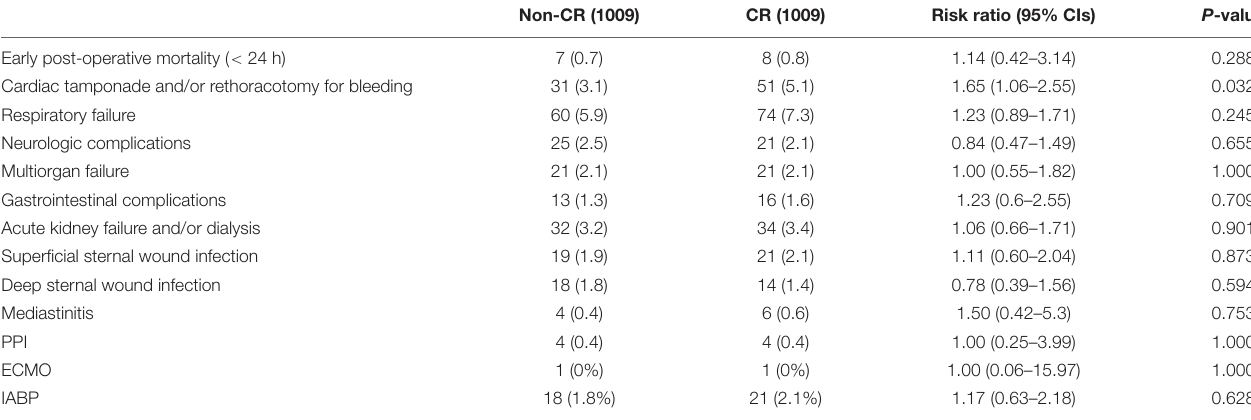
TABLE 4 | In-hospital outcomes after PS-matching.